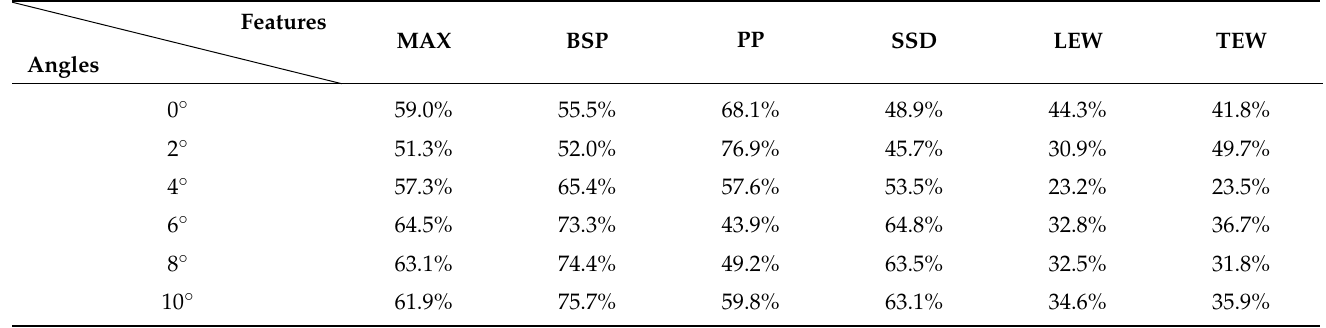
Table 5. Overall accuracies of waveform features at small incidence angles using a Gaussian kernel. Features